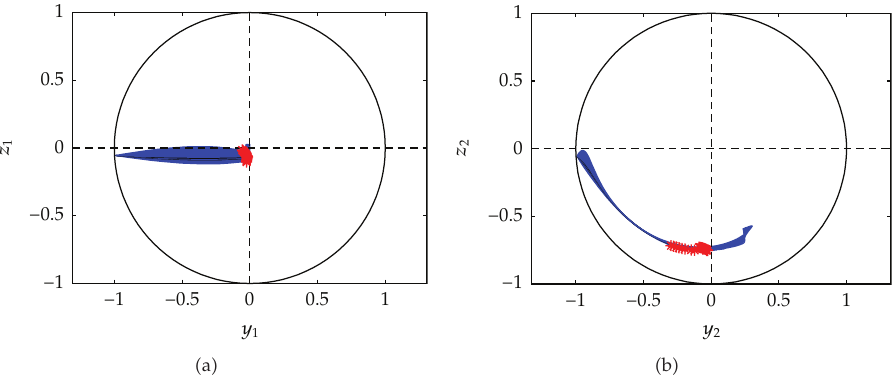
Figure 5: It is the same as Figure 3, but the conjugate points are computed along the singular extremals. Their positions are represented by red crosses.